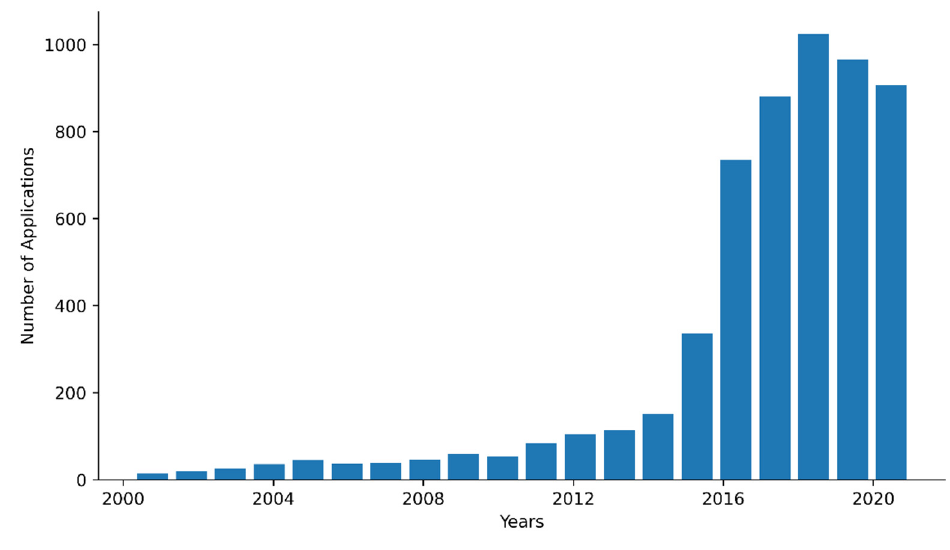
Figure 6. Collected UAV patent data.